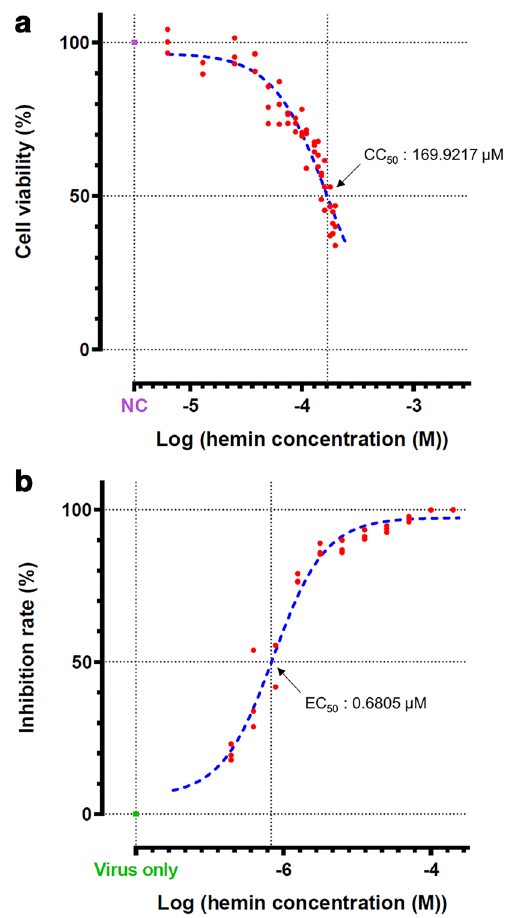
Figure 2. Pharmacological properties of hemin. ( a ) Viability percentages (compared with that of hemin- untreated cells) of Vero76 cells and ( b ) rate of SARS-CoV-2 inhibition at 72 h post-treatment with the indicated concentrations of hemin. Data are presented as the mean ± standard deviation of at least three independent experiments.